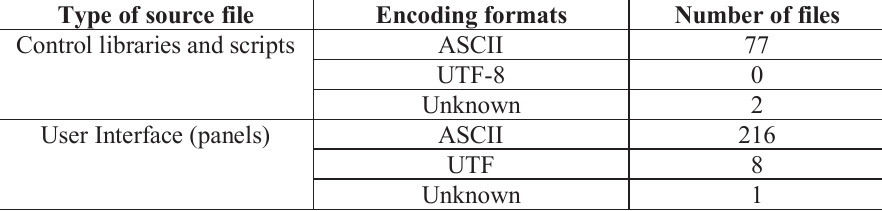
Fig. 1. Migration from a single Subversion code repository to a hierarchy of Git repositories.